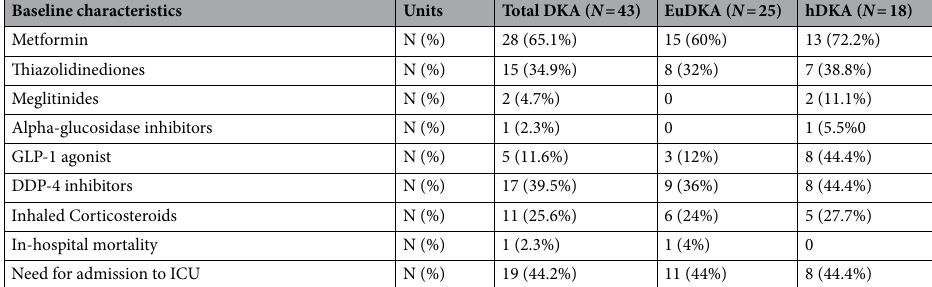
Table 1. Demographics, clinical characteristics, and outcomes of type 2 diabetes mellitus patients on SGLT2i who developed EuDKA or hDKA. T2D: Type 2 diabetes mellitus, SGLT2i: Sodium-glucose co-transporter 2 inhibitors, MENA: Middle East and North Africa EuDKA: Euglycemic diabetic ketoacidosis, hDKA: Hyperglycaemic diabetic ketoacidosis, GLP-1: glucagon-like peptide-1, DPP-4: dipeptidyl-peptidase-4, ICU: intensive care unit, NA: Not